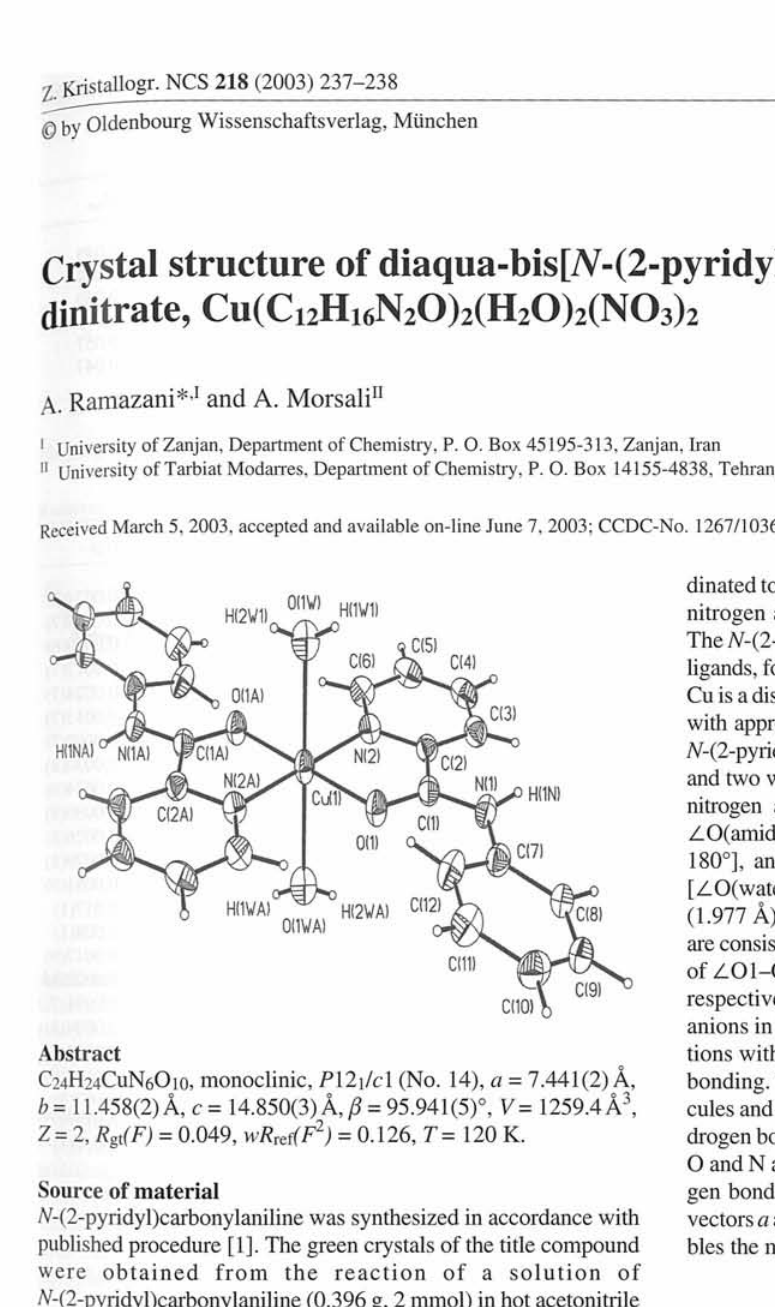
Table 1. Data collection and handling.